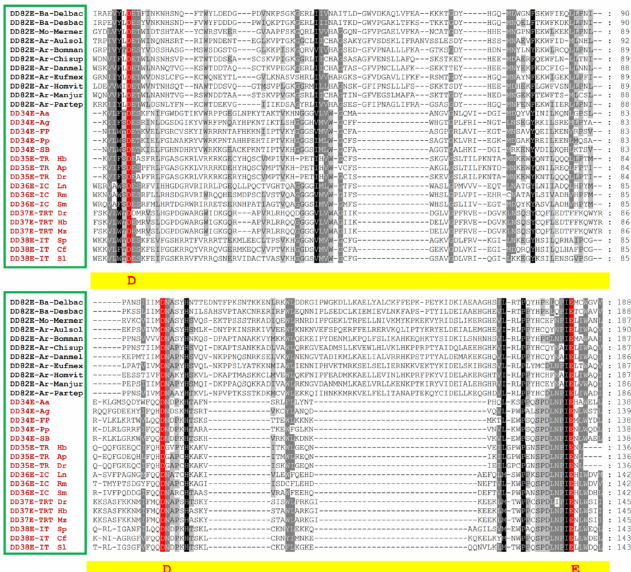
Figure 1. Schematic diagram of the catalytic domains of transposases, which include DD82E/ Sailor ,